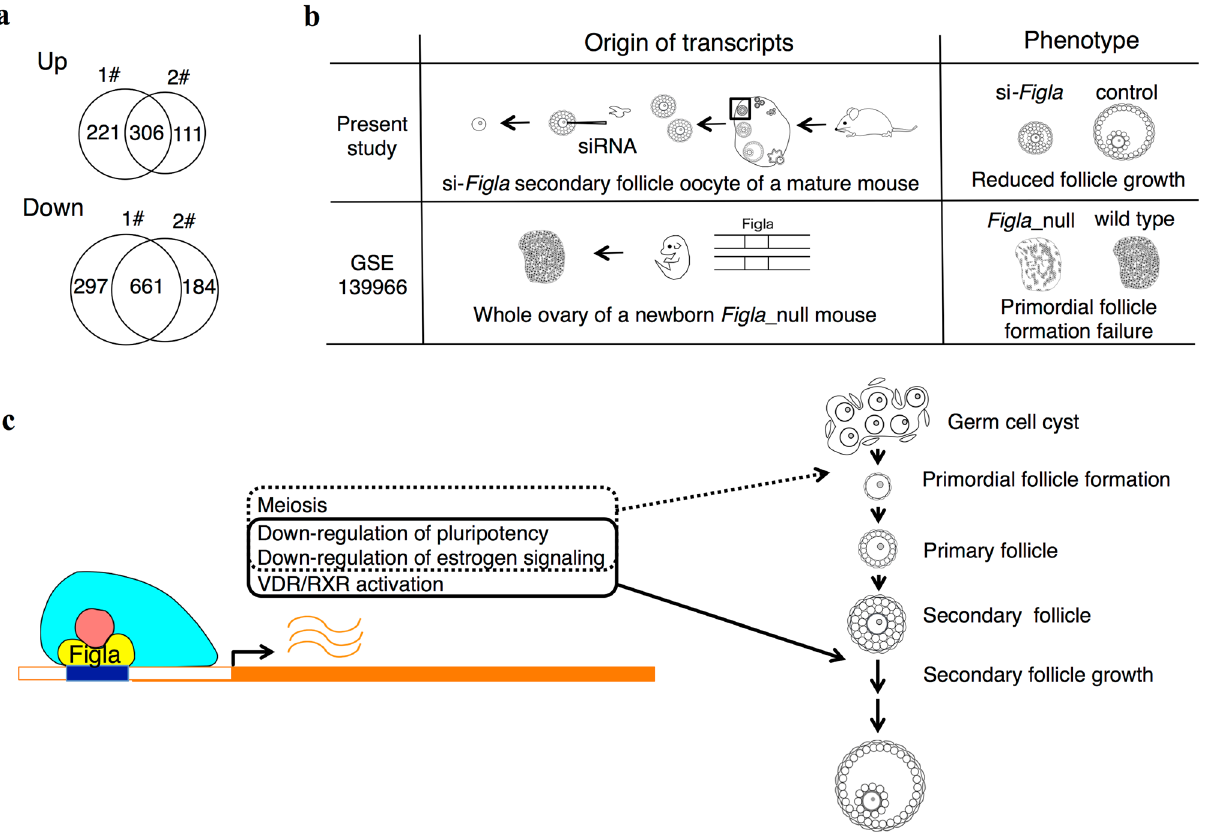
Figure 4. Pursuit of downstream genes of Figla . ( a ) Venn diagram of DEGs in two comparisons, si- Figla 1# vs control (1#) and si- Figla 2# vs control (2#). Four samples for each were compared. In total, 306 genes were up-regulated and 661 genes were down-regulated in these two si- Figla s. ( b ) Schematic of transcripts and phenotypes of the present study and GSE 139966. ( c ) Schematic of the hypothetical model of Figla functions in folliculogenesis. Figla may regulate the follicle growth of secondary follicles by down-regulating pluripotency and estrogen signaling and up-regulating VDR/RXR activation (solid line), whereas Figla may regulate primordial follicle formation through the activation of meiosis and down-regulation of pluripotency and estrogen signaling (dotted